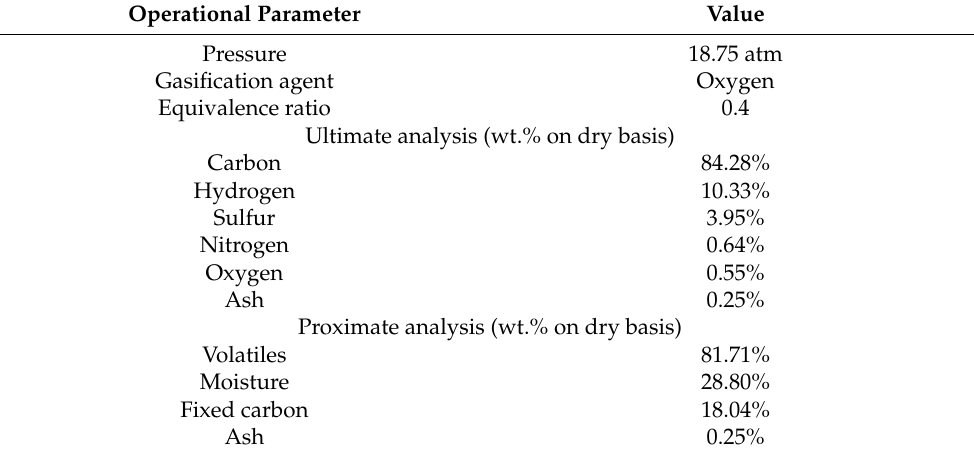
Table 4. Fuel characterization and operational parameters for model verification [31].